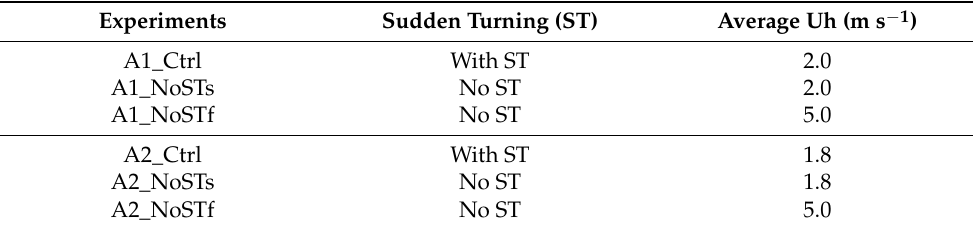
Table 1. Model settings for the 3DPWP experiments.